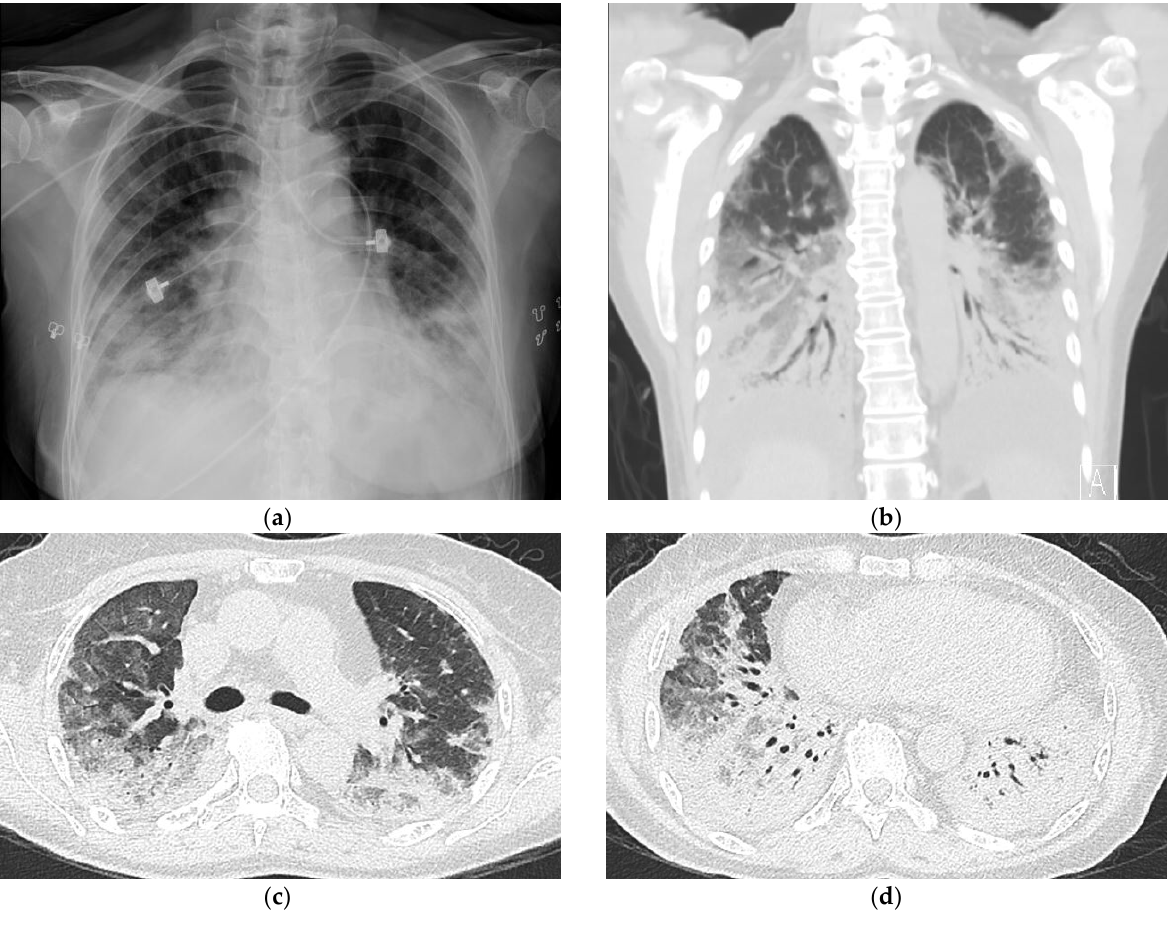
Figure 2. Chest imaging upon admission to the intensive care unit ( a ) Chest radiograph revealed new development of bibasilar consolidations. ( b – d ) Computed tomography scans revealed consolidations and increased ground-glass opacities over the bilateral lungs.